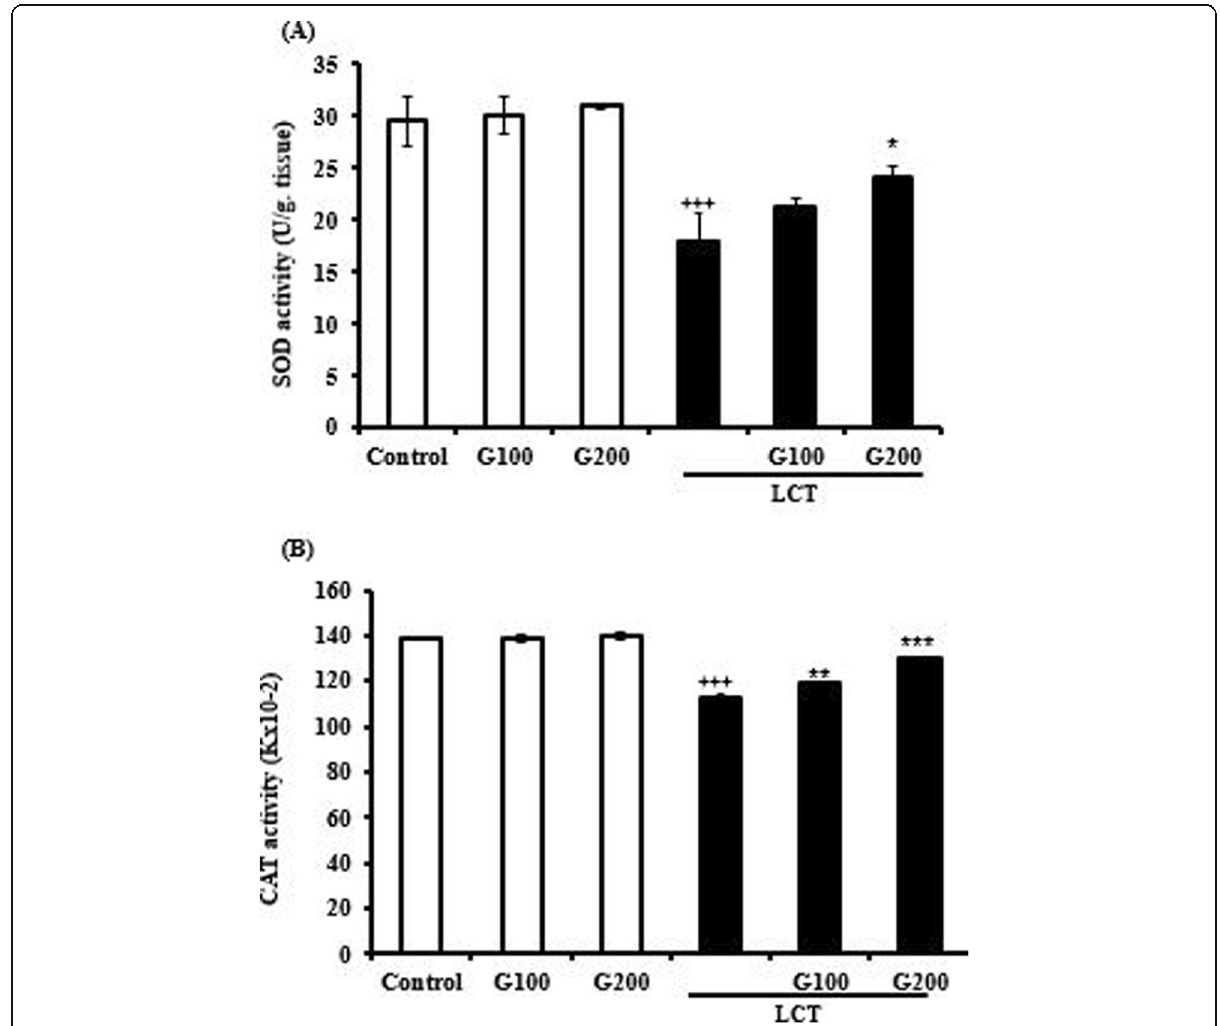
Fig. 4 Effect of Panax ginseng on lambda cyhalotherin-induced changes in liver enzymatic antioxidant defenses a superoxide dismutase (SOD) and b catalase (CAT) activities. The results were expressed as mean ± SE ( N = 6). Where G100, 100 mg Panax ginseng ; G200, 200 mg Panax ginseng ; LCT, lambda cyhalotherin administered rats. Values were considered significantly different at +++ P < 0.001 versus control group and * P < 0.05, ** P < 0.01, *** P < 0.001 versus LCT